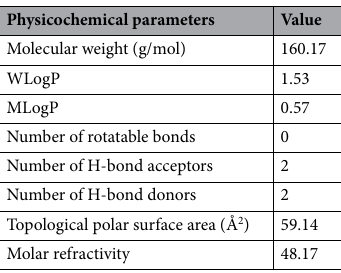
Table 1. Physicochemical properties of 5A8HQ acquired from SwissADME. MLogP and WLogP are the calculated n-octanol/water partition coefficients derived from Moriguchi’s and Daina’s calculation methods, respectively 35 .